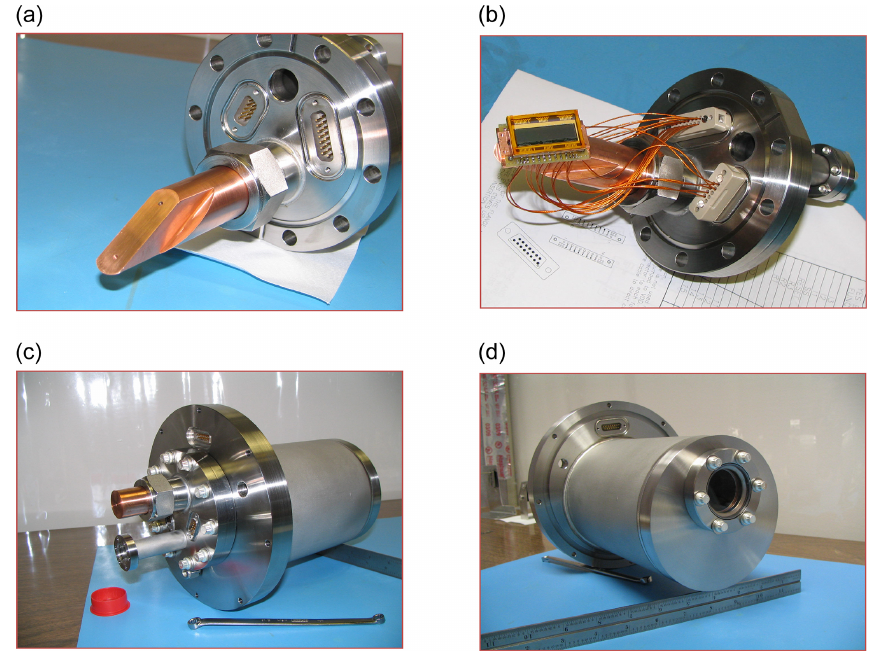
Figure 1. (a) The cold finger that is held at 20 ◦ C. (b) The CCD detector that mounts on the copper cold finger. (c, d) The back and front, respectively, of the assembled housing. The CCD detector is behind the